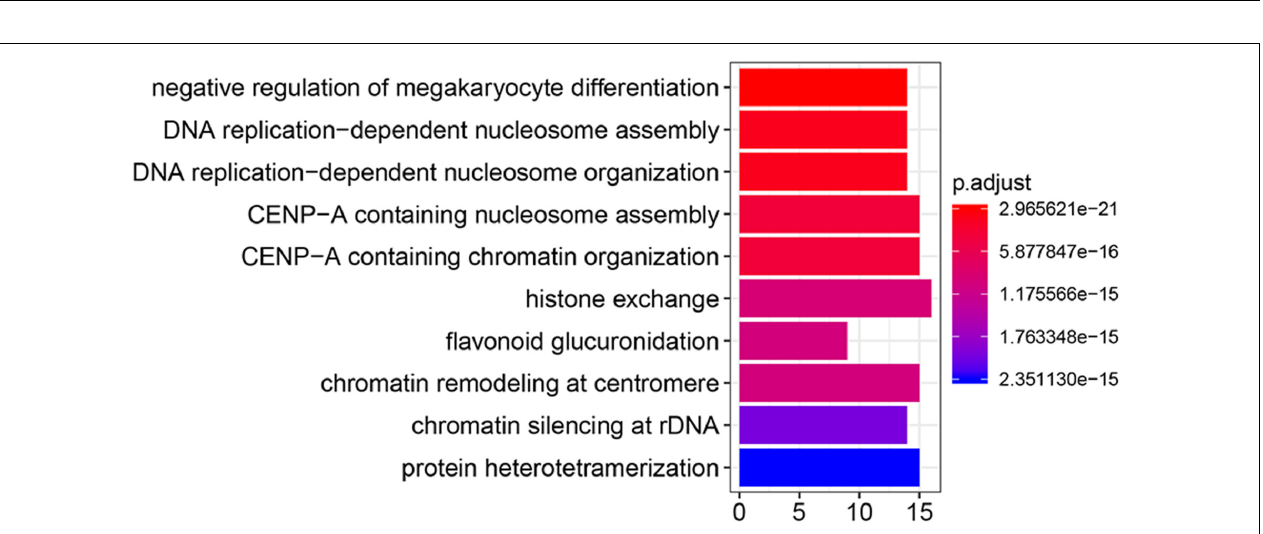
FIGURE 3 | The differentially expressed genes between WASL knockdown group and normal control group. (A) Volcano plot depicting the overall distribution of gene expressions between the two groups. (B) heatmap depicting the expression levels of differentially expressed genes.